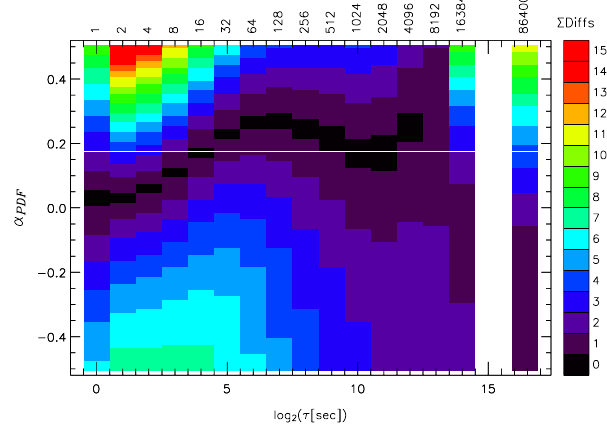
Fig. 7. The gradients of the weighted least squares fits ζ ( m) esti- mated from Fig. 6 versus order m over the range m = 0 to 6. The error bars are drawn at the 3 σ level. The gradient of the weighted least squares curve to the ζ ( m) points gives α GSF =0.126 ± 0.004 (1 σ fit error). The 1 σ fit error is a relative measure of departure from linearity, and thus possible multi-fractal behaviour.